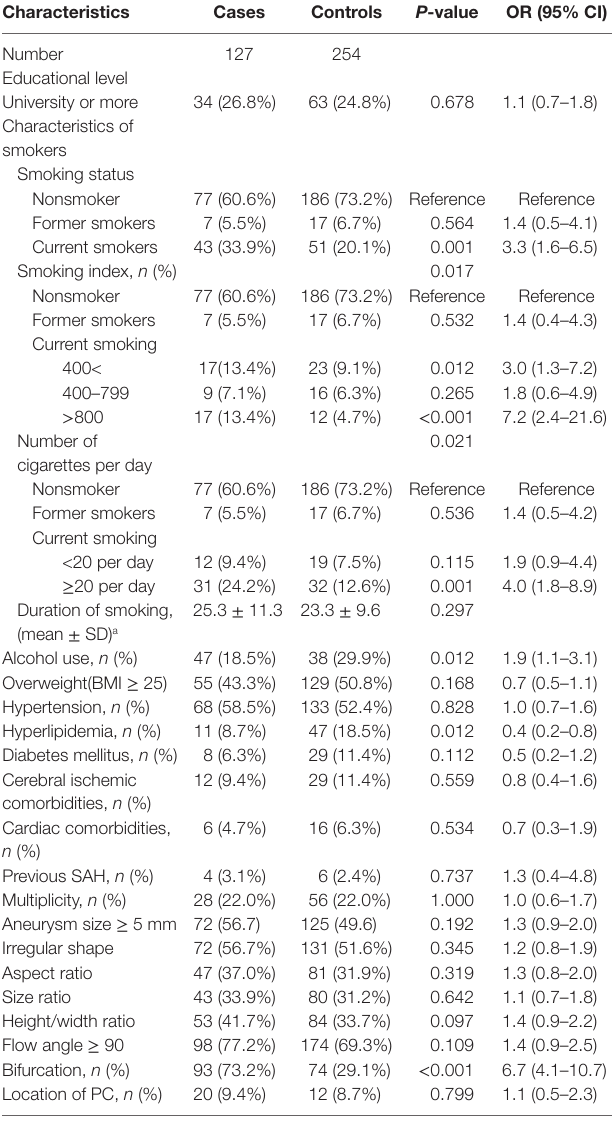
TaBle 2 | Frequency and odds of vascular risk factors in cases compared to controls.